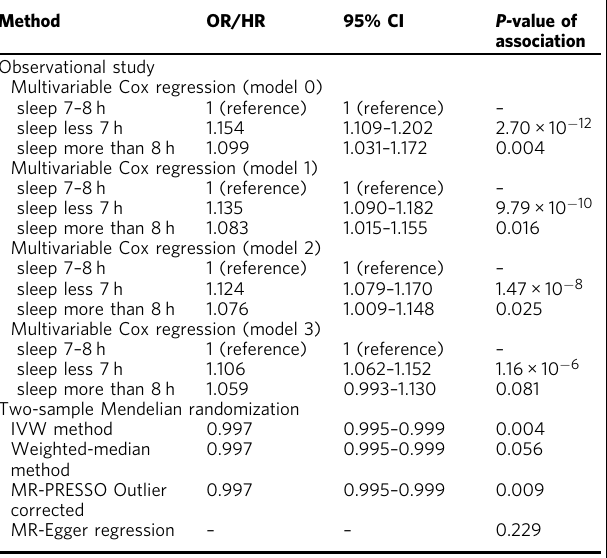
Model 2 = Model 0 + falls; Model 3 = Model 0 + BMD + falls. * the P -value of the intercept term. Abbreviations: BMD bonemineral density,CI con fi dence interval,HR hazardratio, IVW inverse- variance weighted, MR Mendelian randomization, MR-PRESSO MR pleiotropy residual sum and outlier, OR odds